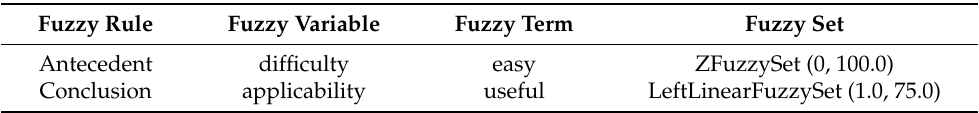
Table 1. The fuzzy rule for Inventive Standard 1.1.4 .